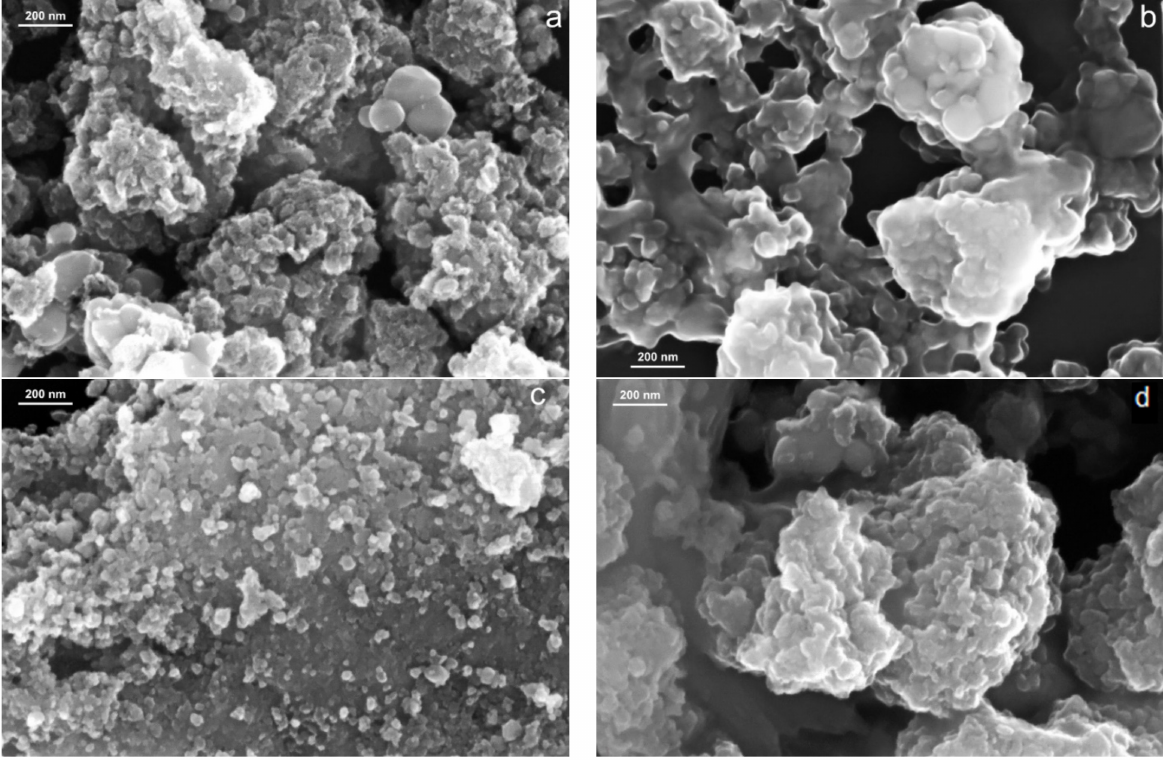
Figure 1. SEM images at 100,000 × magnification of ( a ) TiO 2 sample, ( b ) TiO 2 -TAPP sample, ( c ) TiO 2 - TCPP sample, ( d ) TiO 2 -TMPP